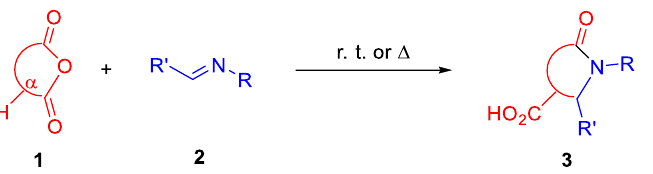
Figure 1. The Castagnoli–Cushman